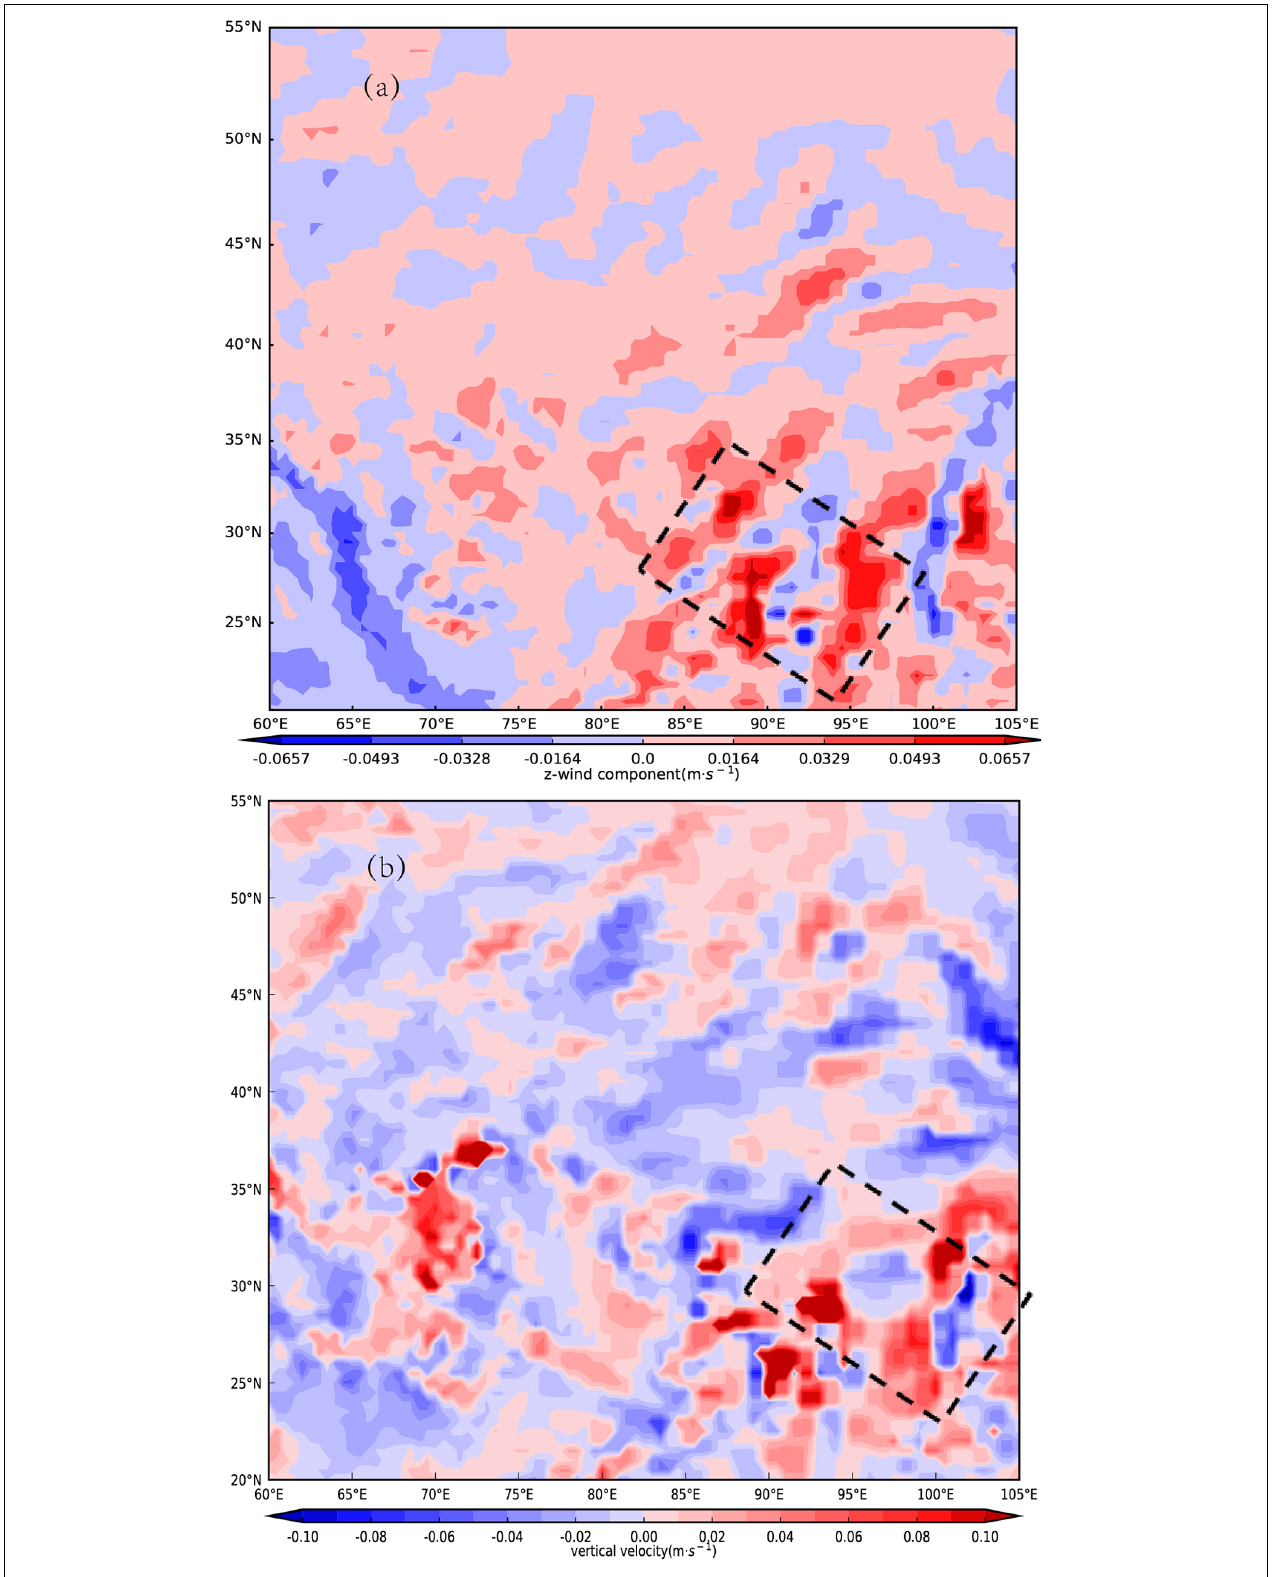
FIGURE 8 | WRF-model simulation of vertical velocity (unit: m s − 1 ) at (a) 100 hPa and (b) 400 hPa over the Tibetan Plateau at 19:20 on 3 May, 2014.